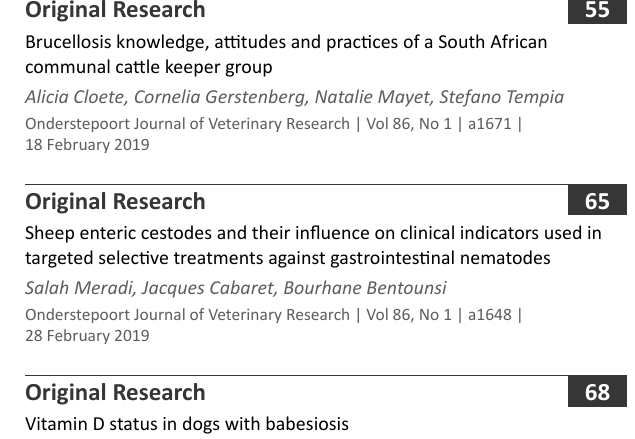
Brucellosis knowledge, attitudes and practices of a South African communal cattle keeper group